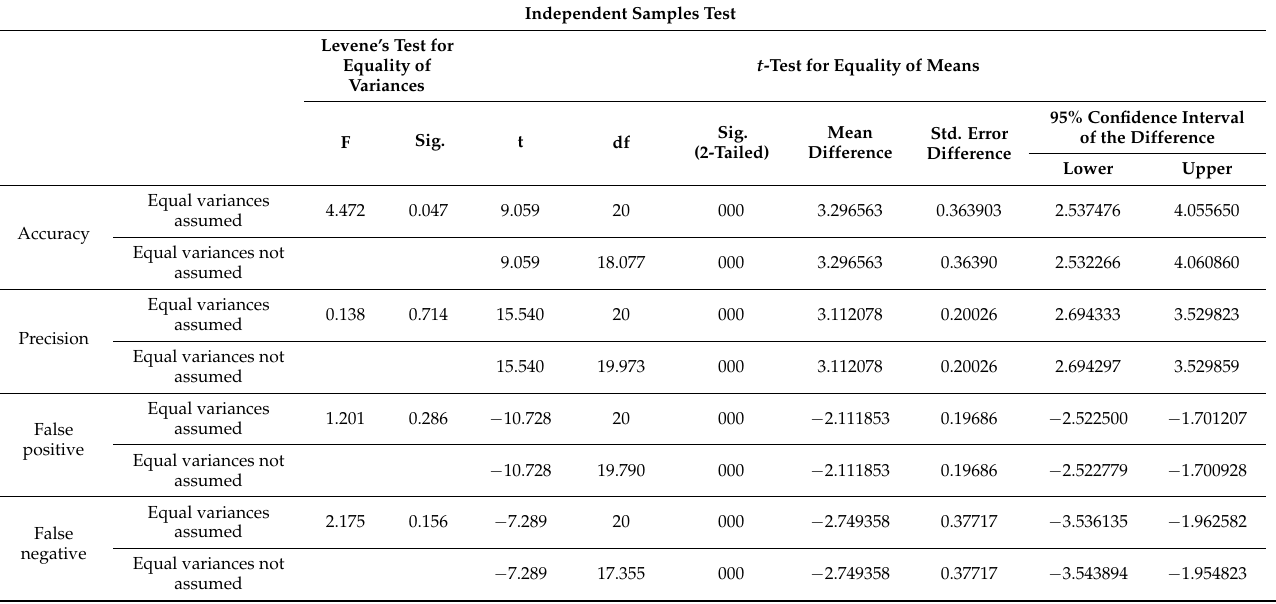
Table 9. CNN and SVM algorithm-based malicious information identification independent sam- ples